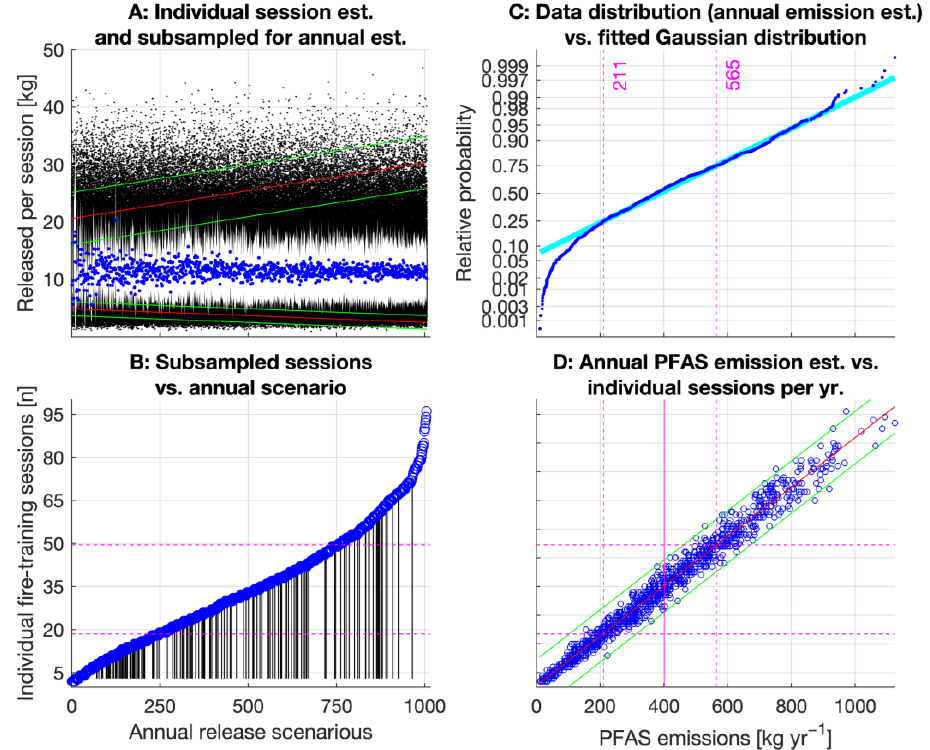
Figure 2. Evaluation the PFAS emission scenarios. ( A ) black dots represent simulated individual PFAS emission scenarios (corresponding to an individual fire-training session); blue dots represent the mean of the subsampled n-scenarios with white area corresponding to ± one standard deviation; red line at top and bottom represent the maximum and minimum of the subsampled n-scenarios, respectively, with green lines corresponding to ± one standard error. Vertical axe corresponds the variation in individual emission scenarios and horizontal axe corresponds to set of individual samples (n = 20,000 × 1005). ( B ) blue circles indicate the number of subsampled session scenarios in A; vertical black lines correspond to suggested most-likely exercise routine with 3 consequent training days per annual exercise occurrence. ( C ) comparison of the distribution of the simulated annual release scenarios (blue dots) vs. fitted Gaussian distribution (cyan); vertical dashed magenta lines correspond to first and third quantiles of the data. ( D ) Estimates on annual PFAS emission (blue line) vs. number of individual training sessions, shown as a linear fit with green line corresponding to ± three standard deviations; vertical magenta line corresponds to estimated median, vertical black line corresponds estimated mean, and dashed magenta lines correspond to first and third quantiles of the data.